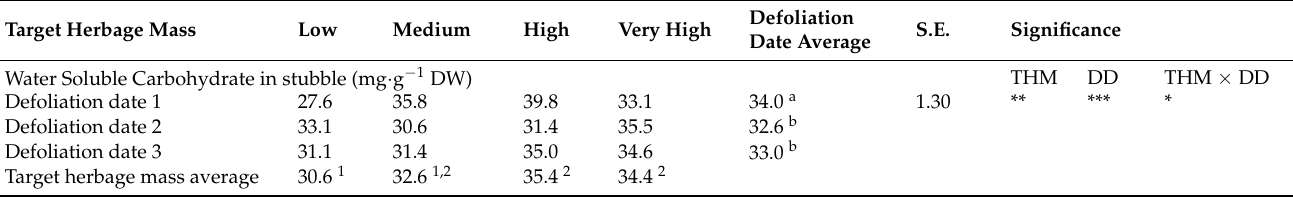
Table 4. Effect of the interaction of target herbage mass (Low—500 kg · DM · ha − 1 , Medium—1500 kg · DM · ha − 1 , High— 2000 kg · DM · ha − 1 and Very high—3000 kg · DM · ha − 1 ) and defoliation dates (DD; DD1—15 October, DD2—7 November and DD3—21 November) at defoliation in autumn on the water soluble carbohydrates (WSC; mg · g − 1 DW) in the stubble (<3.5 cm) and the light interception (%) to the base of the